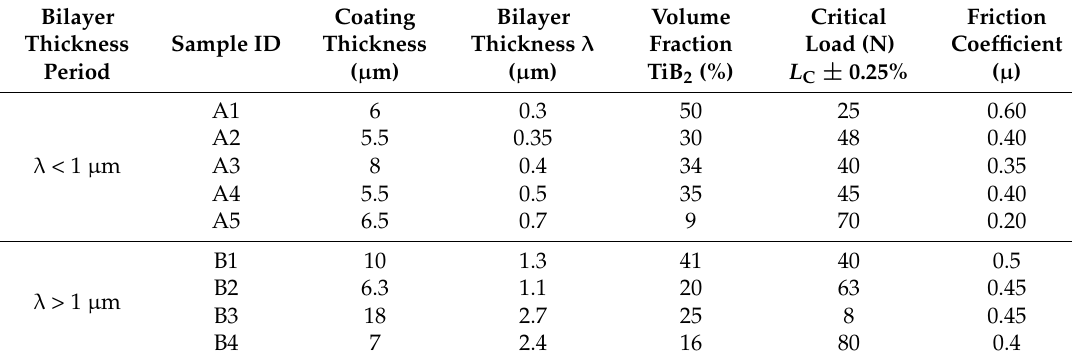
Table 1. Multilayer coatings of TiAlN/TiB 2 deposited in this study. Coatings from set A have a bilayer thickness <1 µ m and coatings from set B have a bilayer >1 µ m. The critical loads ( L C ) and the friction coefficients ( µ ) are measured from the scratch